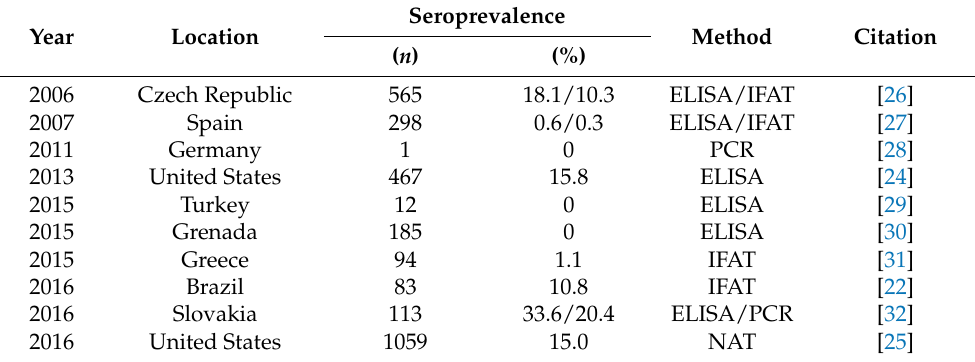
Table 1. Summary of published studies examining Neospora caninum in wild pigs.